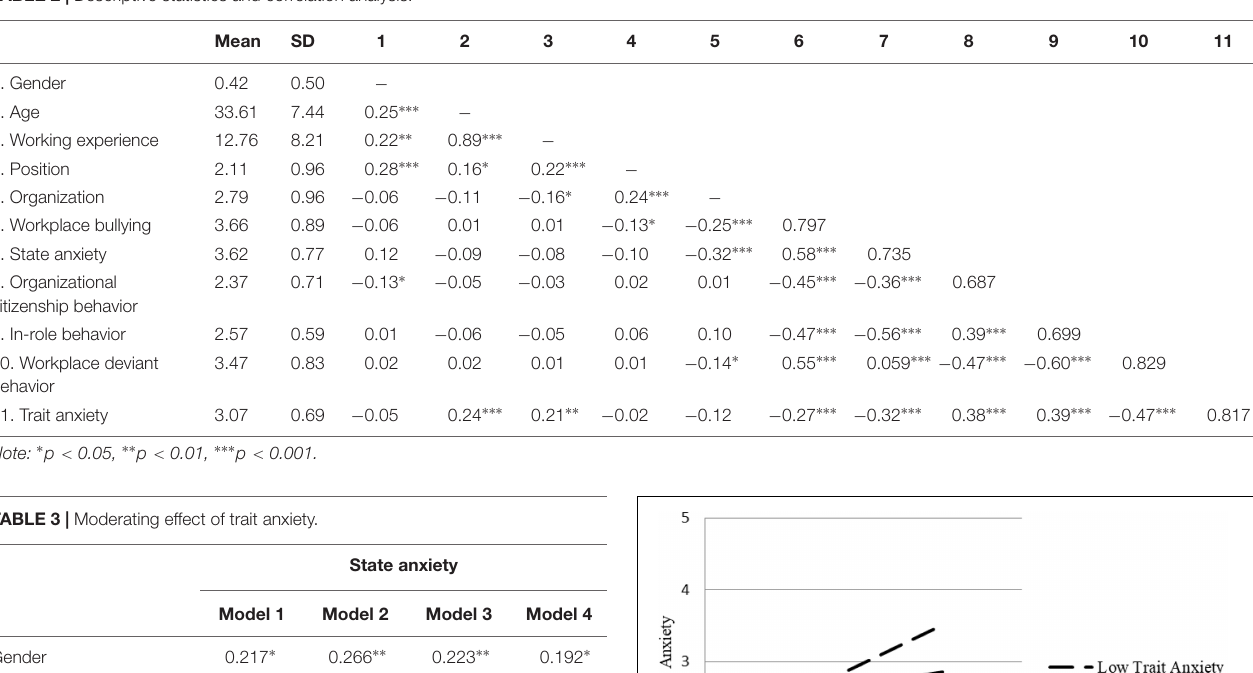
TABLE 2 | Descriptive statistics and correlation analysis.